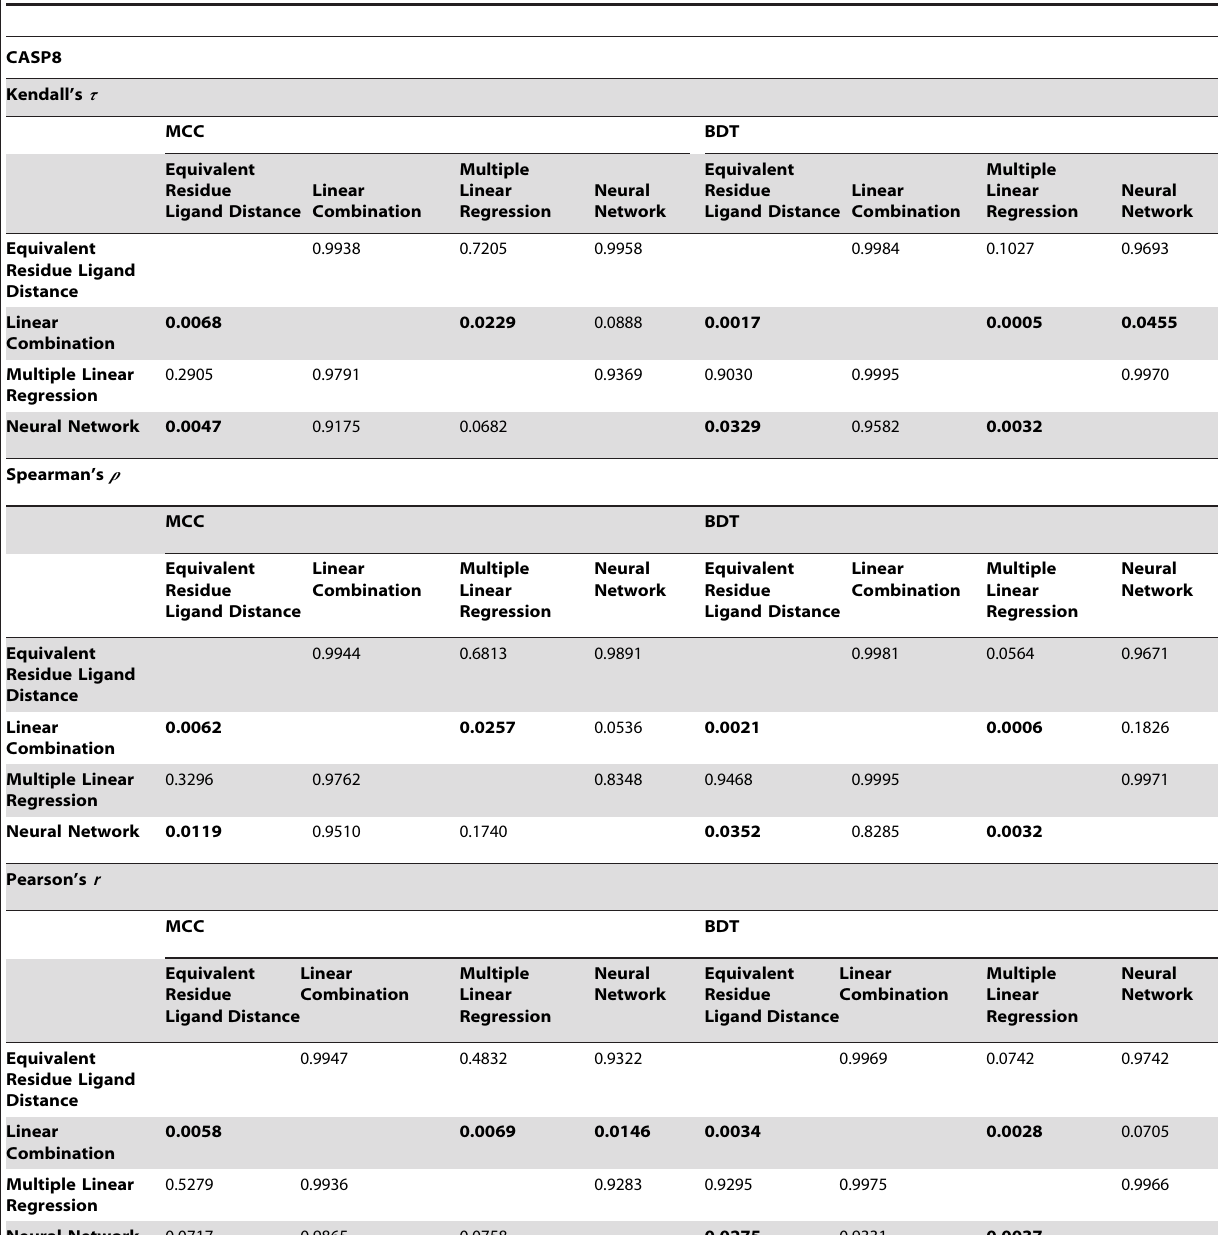
Table 2. All versus all Wilcoxon signed ranked sum test analysis, to determine of a significant difference exists between the scoring methods (CASP8